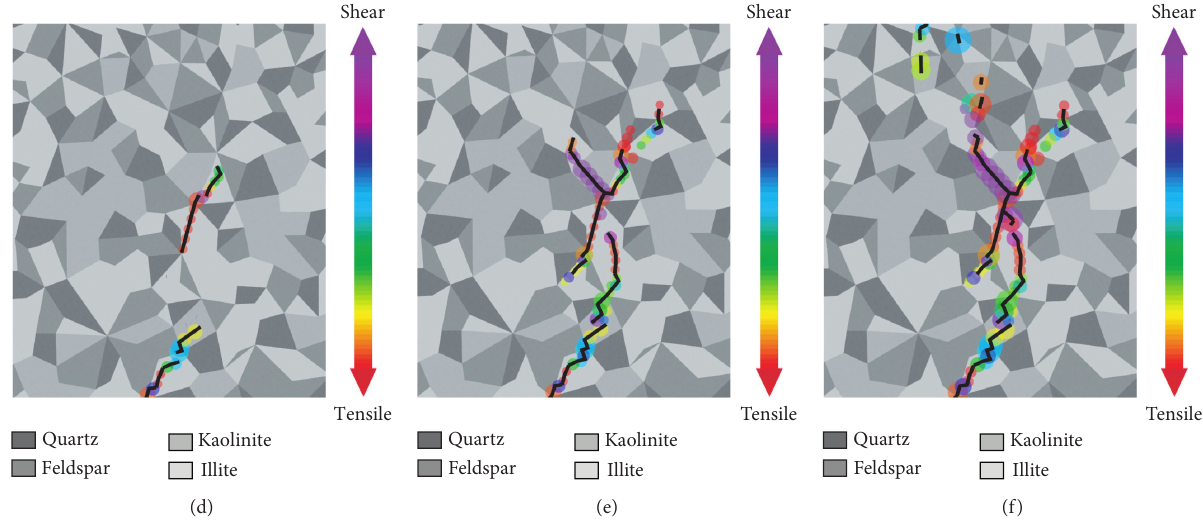
Figure 13: X fracture formation and AE location for loading methods I ((a), (b), (c)) and IV ((d), (e), (f)). Red dots are the AE location of tensile fractures, purple dots are the AE location of shear fractures, and the colors between the two are the AE location of tensile-shear fractures. The size of the dot represents the level of AE